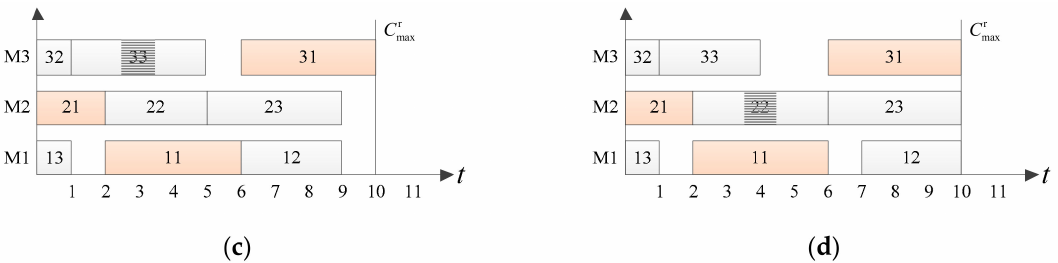
Figure 3. The relationship between the makespan delay and the machine breakdowns on di ff erent operations. ( a ) No machine breakdown; ( b ) a machine breakdown on operation O 11 ; ( c ) a machine breakdown on operation O 33 ; ( d ) a machine breakdown on operation O 22